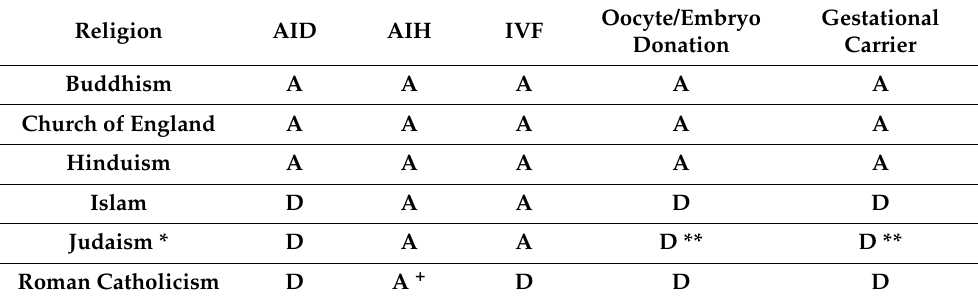
Table 4. Religious views on fertility preservation